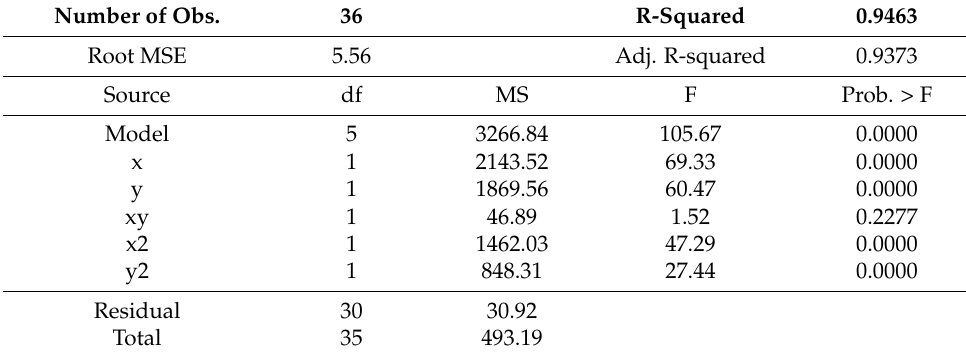
Table 10. ANOVA analysis with all